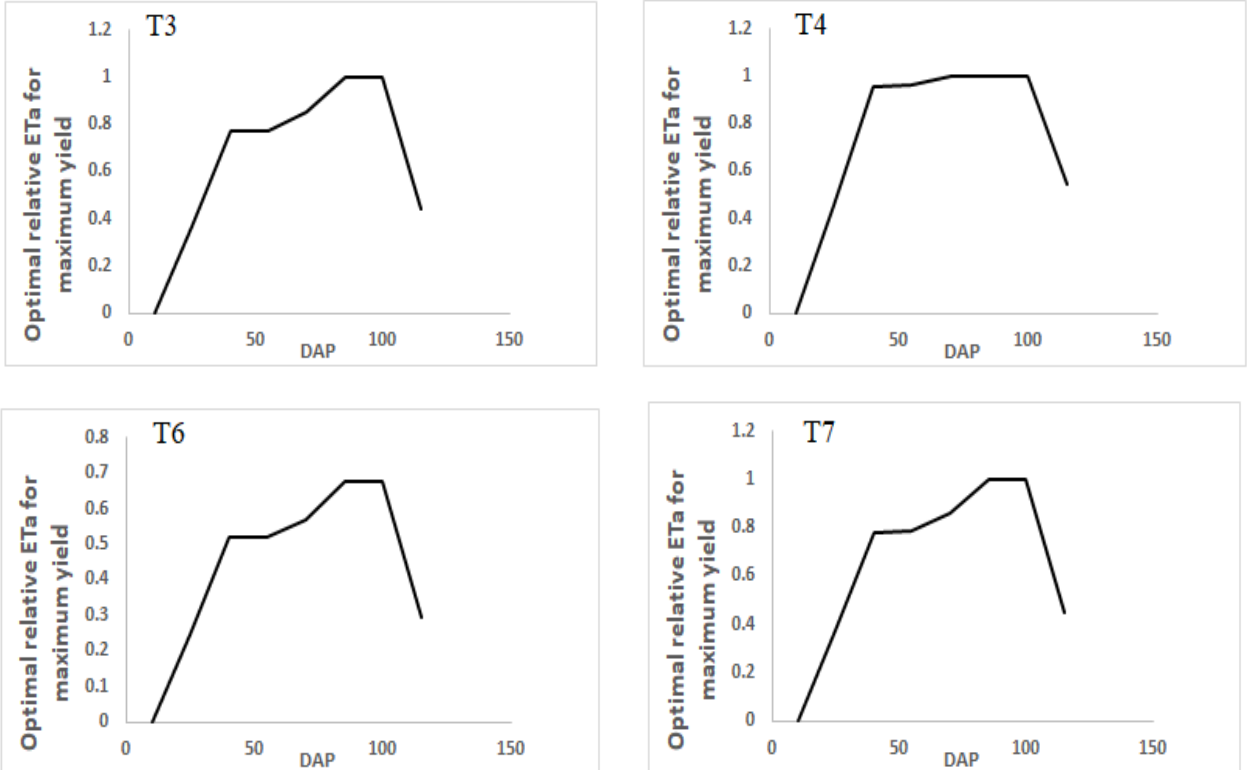
Figure 8. Optimal relative ETa for potato under different levels of seasonal-irrigation water.